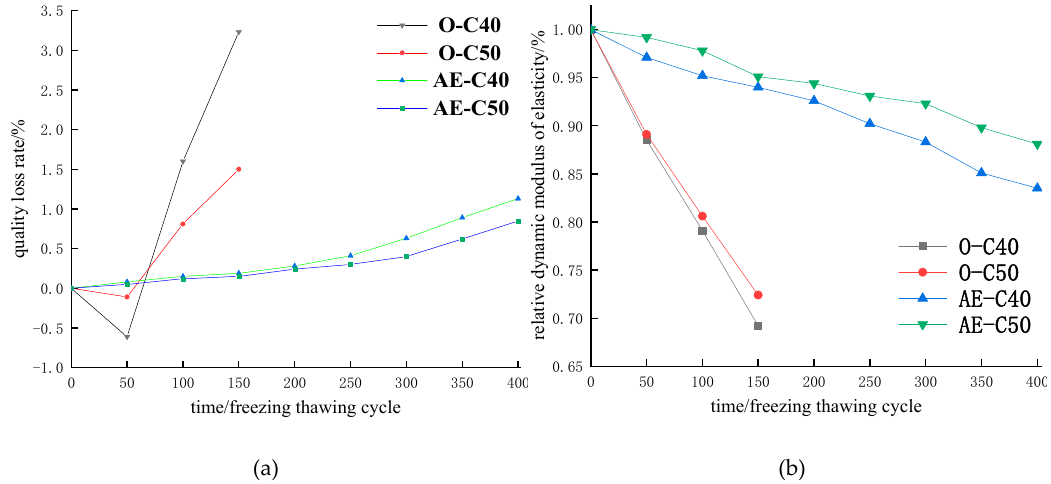
Figure 3. Mass loss rate and relative dynamic elastic modulus of concrete after freeze–thaw cycles: ( a ) quality loss rate of concrete; ( b ) relative dynamic modulus of elasticity of concrete.